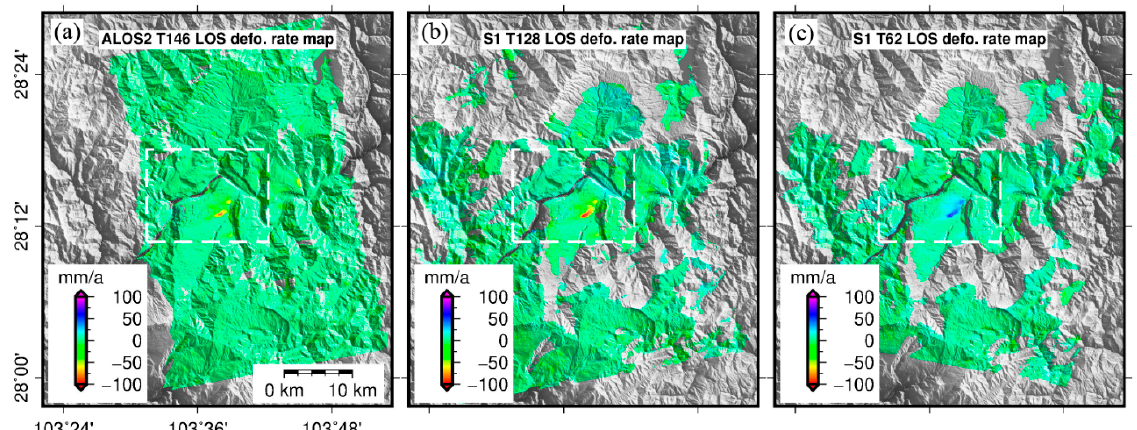
Figure 9. ( a ) Mean velocity map of ALOS2 ascending; ( b ) mean velocity map of Sentinel-1 ascending; ( c ) mean velocity map of Sentinel-1 descending.